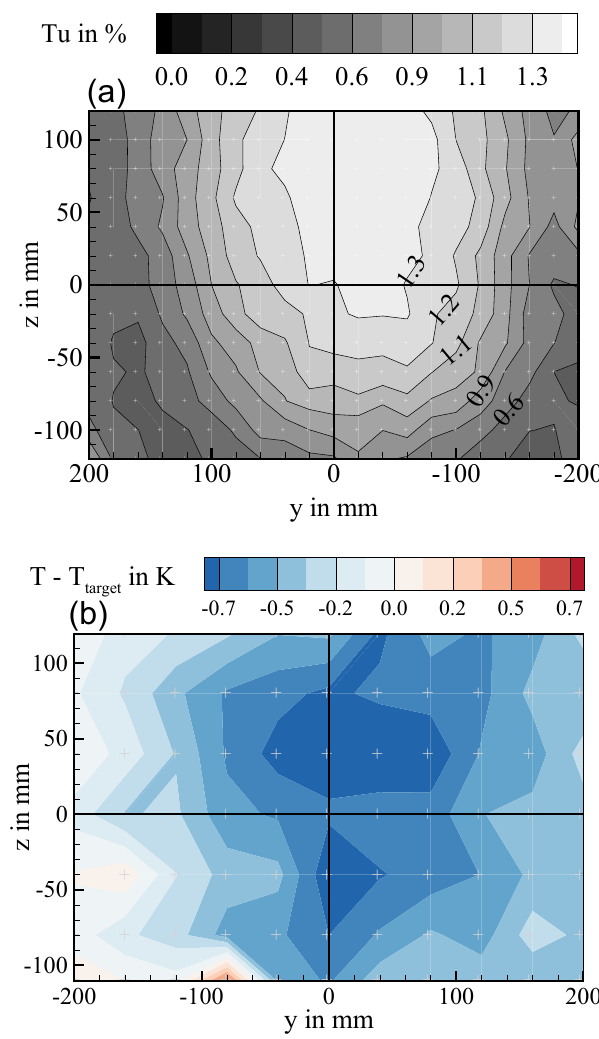
Figure 20. Spatial distribution of turbulence intensity (a) and tem- perature variation (b) for the mixed phase